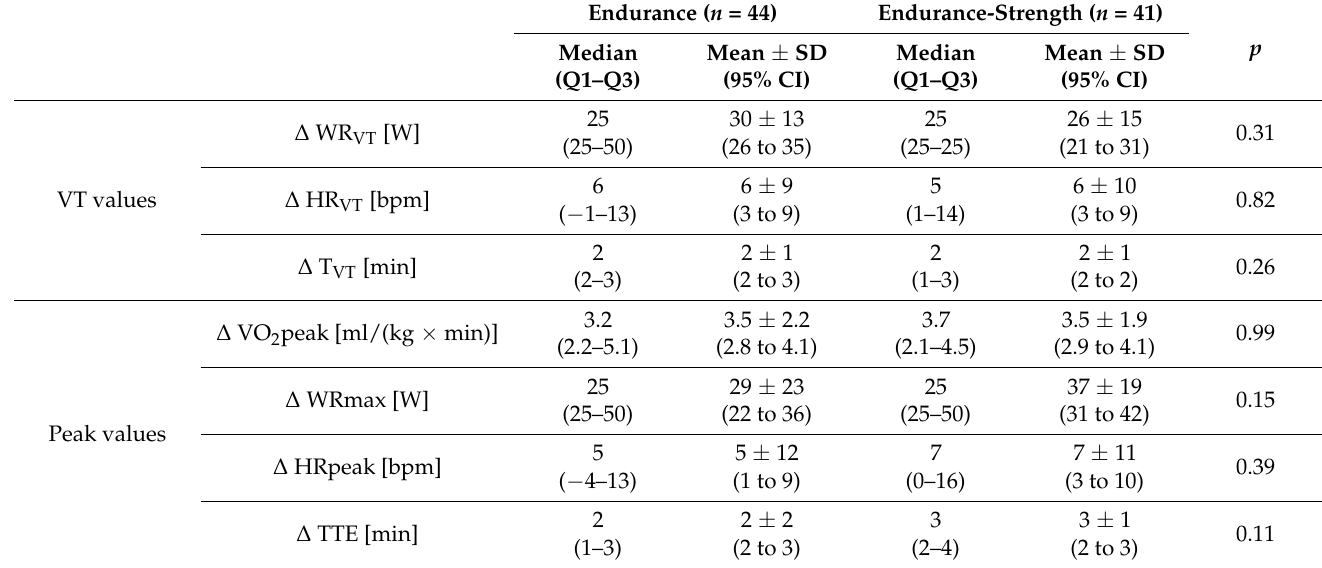
Table 6. Comparison of the effect of endurance ( n = 44) and endurance-strength training ( n = 41) on physical